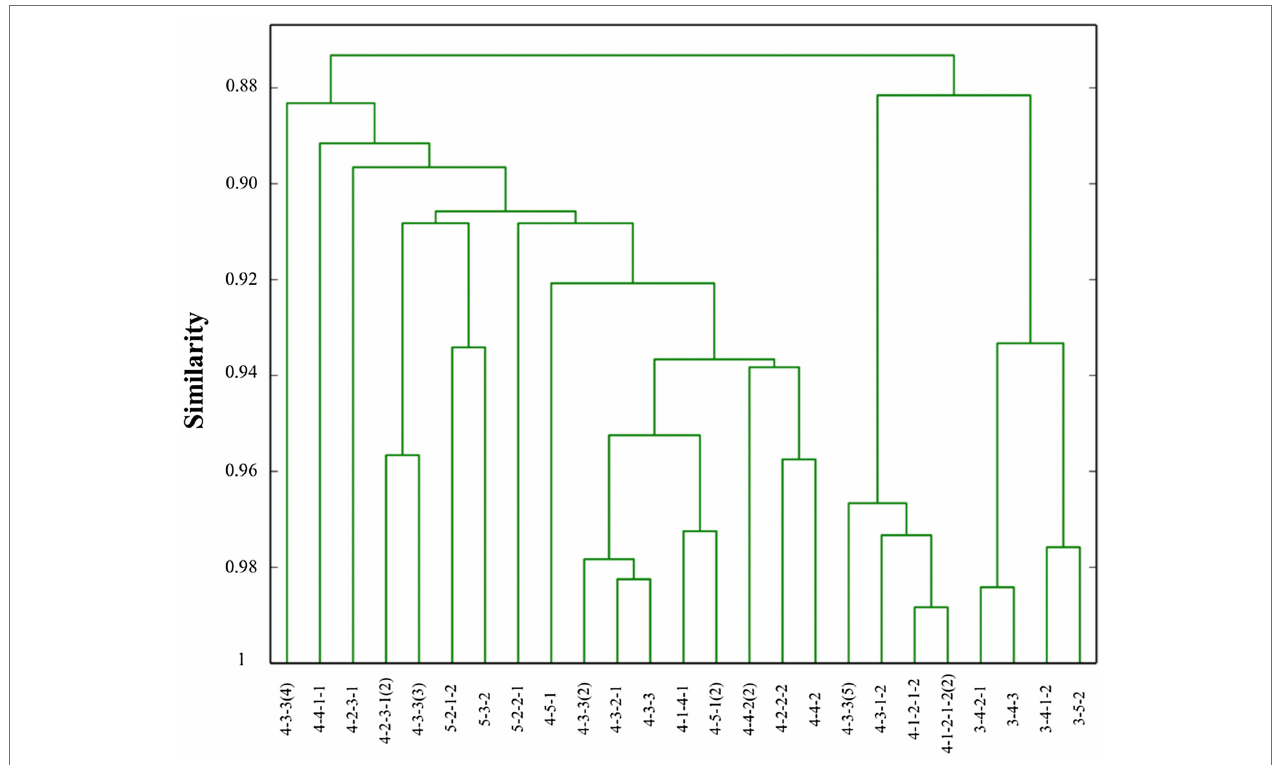
FIGURE 5 | Hierarchical clustering (UPGMA) of the 25 reference team